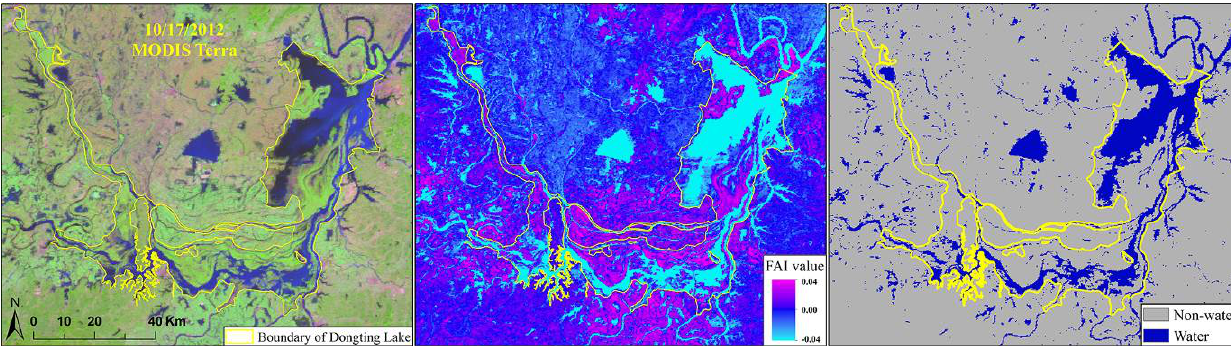
Figure 2. Process and result of water area delineation. The following figures from left to right were MODIS image on 17 October 2012, FAI image, and water image extracted by FAI gradient